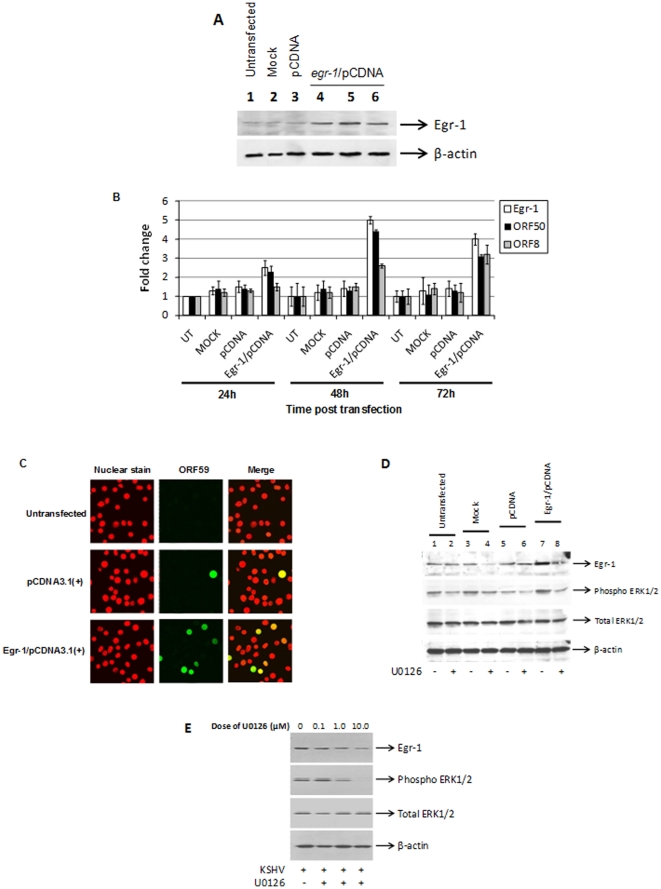
Elevated Egr-1 induces KSHV lytic gene expression.(A) Elevated Egr-1 was observed in cells transfected with egr-1/pCDNA3.1(+). BCBL-1 cells were untransfected, mock transfected, transfected with pcDNA3.1 or egr-1/pcDNA3.1. The cells to be used as controls (lanes 1–3) were incubated at 37°C for 48 h while the cells transfected with egr-1/pcDNA3.1 were incubated for 24, 48, and 72 h, respectively. At the end of incubation, the cells were lysed and the lysates were used to perform Western blotting. (B) Effect of elevated Egr-1 on KSHV ORF50 and ORF8 expression. BCBL-1 cells were untransfected or transfected as described above. RNA was extracted, cDNA was synthesized, and the expression of cellular egr-1; and KSHV encoded ORF50 and ORF8 were analyzed by qRT-PCR. Baseline expression of genes was considered as 1-fold for comparisons. Each point denotes the average±S.D. (error bars) of three experiments. (C) Expression of lytic proteins in BCBL-1 cells transfected with Egr-1. KSHV-infected cells were untransfected, transfected with pcDNA3.1, or egr-1/pcDNA3.1 for 48 h. The stained cells examined using a confocal microscope (magnification ×62). The average number of fluorescent cells were counted over five random fields and used for comparisons. (D) Enhanced egr-1 activates MAPK signaling in BCBL-1 cells. KSHV-infected cells were untransfected, mock-transfected, transfected with pcDNA3.1(+), or egr-1/pcDNA3.1(+) for 48 h. Each group of cells was left untreated or they were treated with 10 µM of U0126 1 h prior to transfection and remained throughout the incubation period. Cell lysates were resolved on a 10% SDS-PAGE, transferred to a PVDF membrane, and Western blotting was performed using specific antibodies. (E) U0126 inhibits phosho-ERK1/2 and Egr-1. Briefly, BCBL-1 cells were treated with different concentrations of U0126. Following 24 h incubation, the cells were lysed and the lysates were used to perform Western blotting as per earlier protocols using specific antibodies.